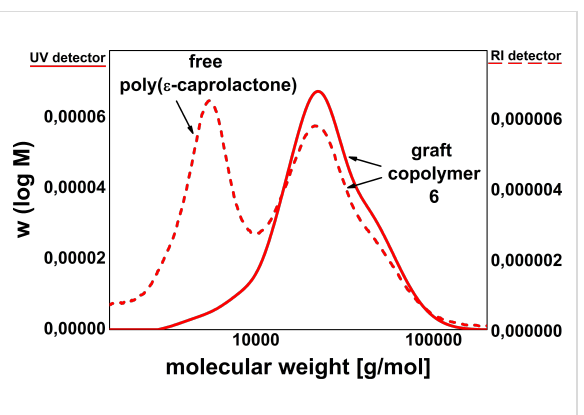
Figure 5: GPC curves of the new formed graft copolymer 6 detected by UV absorption (continuous line) and RI (dashed line). The UV absorption of 6 in the GPC diagram (continuous line) clearly indicates the appearance of the aromatic compounds in a higher molecular weight area in comparison with the original polymer 4 . The molecular weights of polymer 6 are about 18000 g mol − 1 for M n and 27000 g mol − 1 for M w with a mo- lecular weight distribution of M w / M n = 1.5. Additionally, the RI curve (dashed line) shows the existence of some non grafted poly( ε -caprolactone) (PCL) fractions. PCL is probably formed